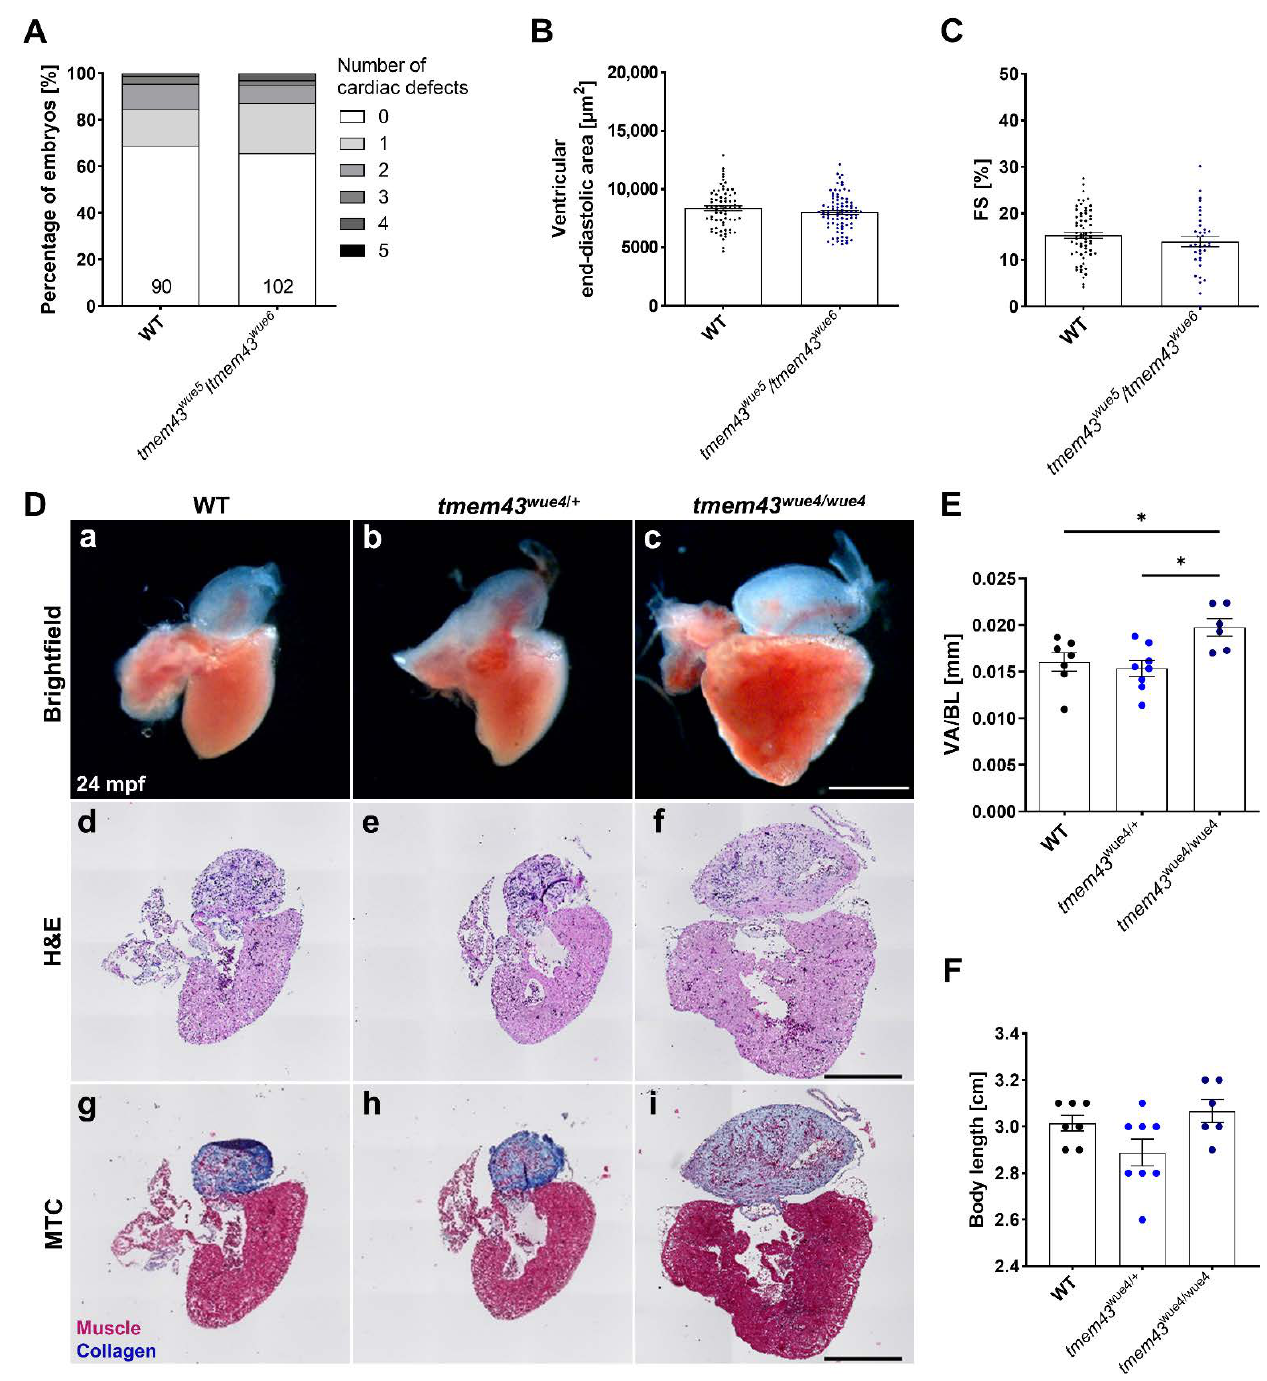
Figure 7. Enlarged adult hearts of homozygous tmem43 wue4/wue4 mutant fish. ( A ) Phenotyping showing the percentage of embryos with zero to five different cardiac-specific defects. The defects were classified in looping defects, pericardial edemas, arrhythmias, altered ventricular shape, strong ventricular contractions, heterogenous ventricular contractions, and altered atrial shape. The number of analyzed embryos is indicated at the bottom of the columns. ( B ) Quantification of ventricular end-diastolic area showing the mean area of three individual sections of each fish from a time series of the embryonic cardiac cycle. ( C ) Analysis of cardiac function by quantification of ventricular fractional shortening (FS) from a time series of the embryonic cardiac cycle. Data points represent the average measurement obtained from three diastolic/systolic phases of each fish. The short axis of the ventricle was used for quantification. ( A – C ) Analyses were performed on embryos from three independent clutches per genotype. ( B , C ) Significance was determined by an unpaired t-test. Error